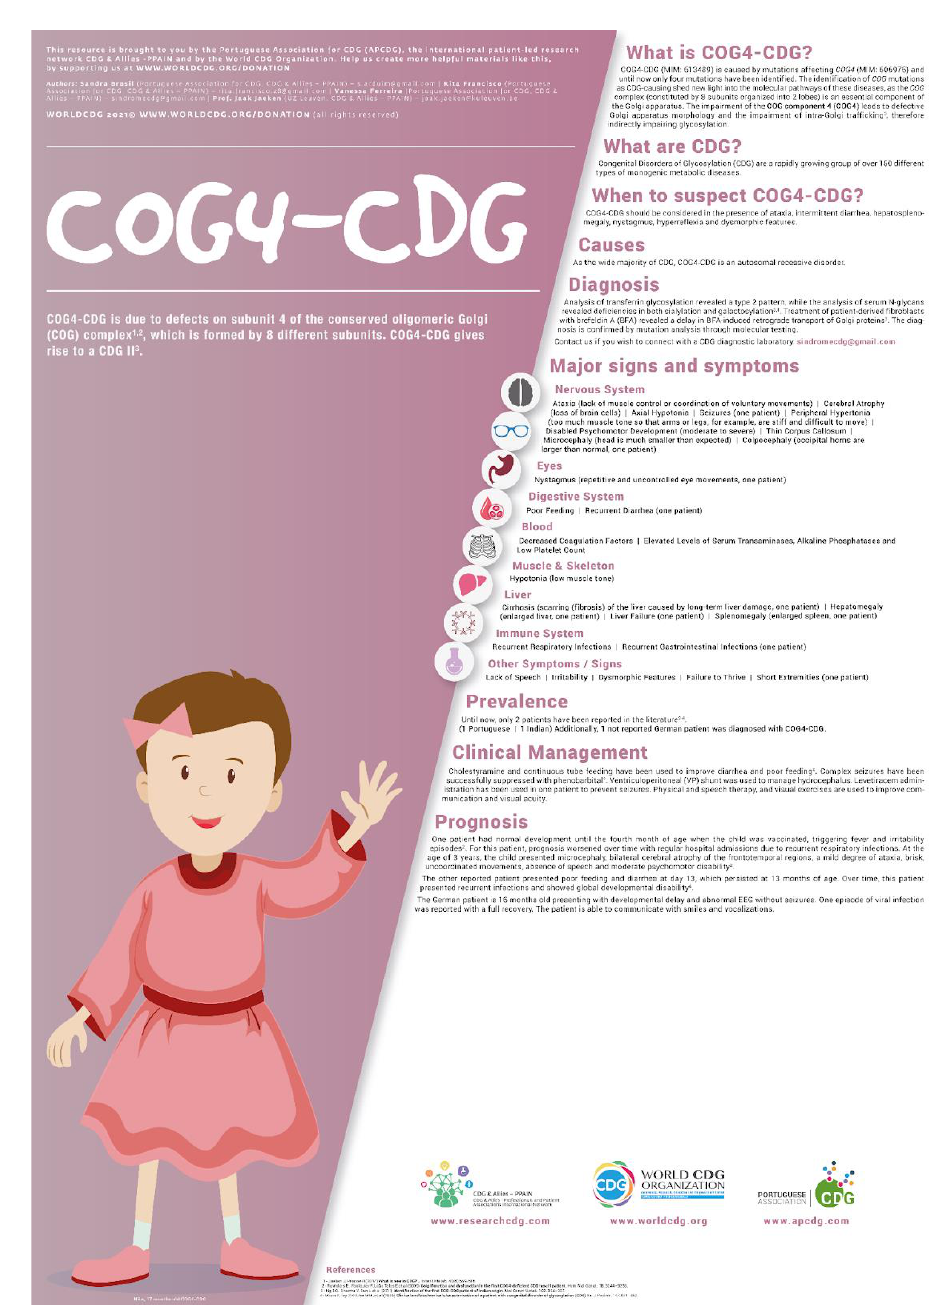
Figure 6. Example of an infographic dedicated to COG4 -CDG. To consult the overall infographics already available check at https://worldcdg.org/ (accessed on 22 November 2022).